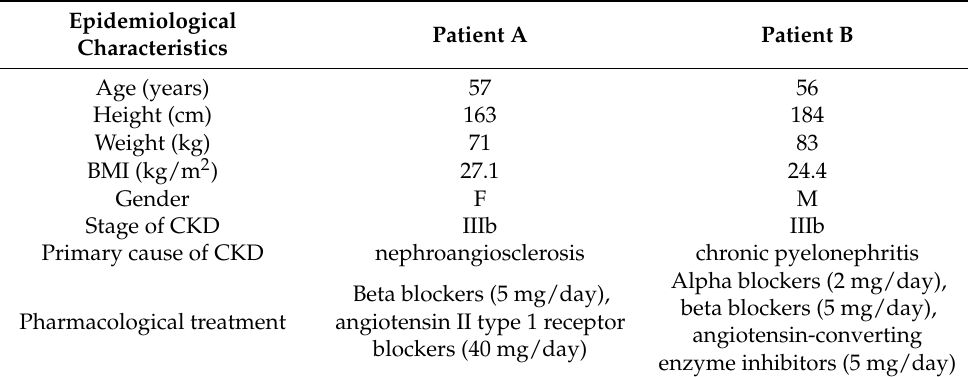
Table 1. Patient A and Patient B baseline